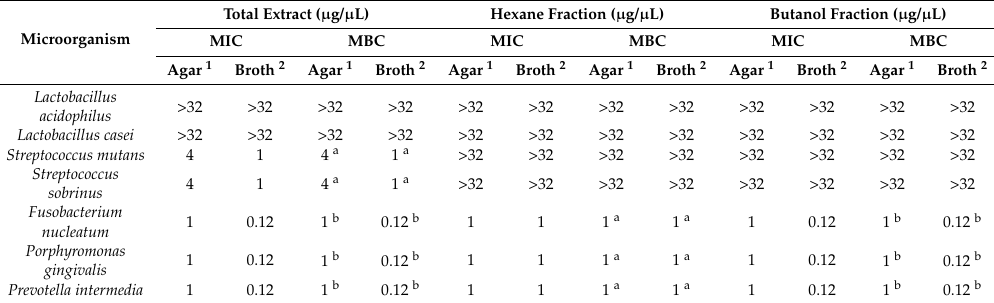
Table 3. Berberis goudotii total extract and fractions ( µ g/ µ L)—Minimum Inhibitory Concentration (MIC) and Bactericidal or Bacteriostatic effects (Minimum Concentration, MBC)